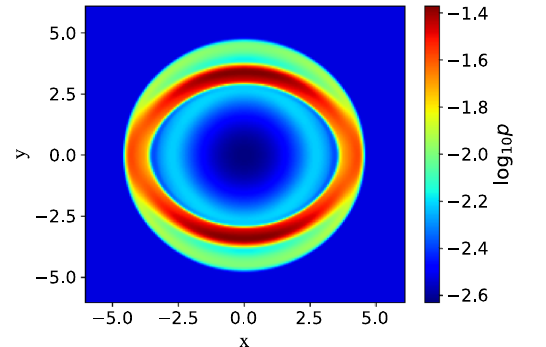
Fig. 9 The scalar potential φ at t = 4 is shown in the 2D cylindrical explosion